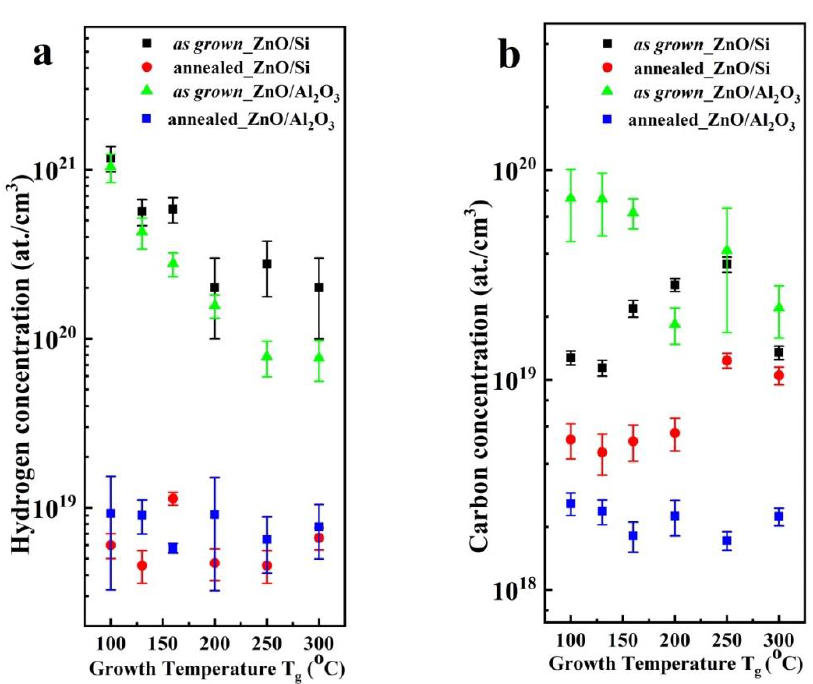
Figure 11. Hydrogen ( a ) and carbon ( b ) concentration in as grown (black squares) and annealed (red squares) ZnO/Si films and as grown (green triangle) and annealed (blue squares) ZnO/a-Al 2 O 3 grown at different T g .